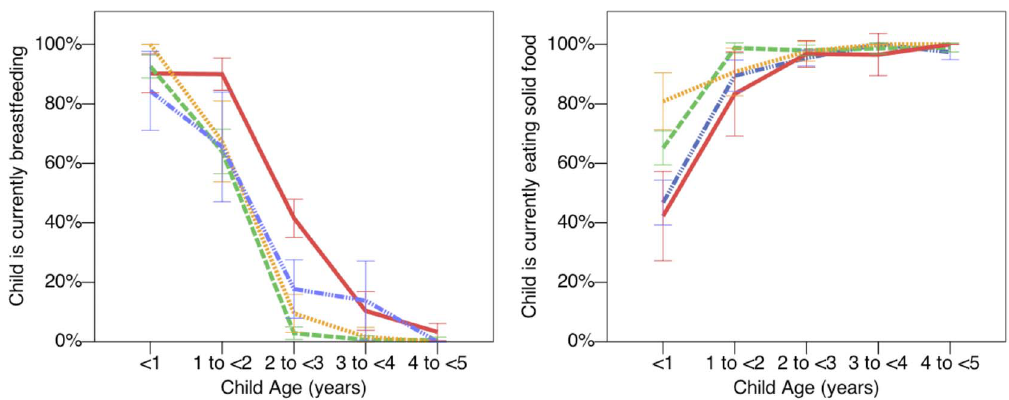
Figure4. Breastfeeding Behaviour by Child Age and Ethnicity. Current patterns indicate relatively delayed weaning in the Maasai compared to other ethnic groups. Red solid line = Maasai children; Orange dotted line = Rangi children; green dashed line = Sukuma children; blue dotted and dashed line = Meru children. Data plotted for all 56 villages. 95% confidence intervals calculated using normal approximation.